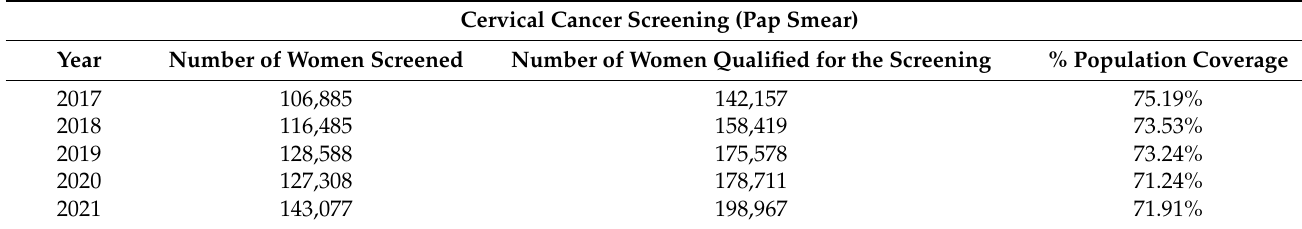
Table 4. Population coverage for privately funded cervical cancer screening. Cervical Cancer Screening (Pap